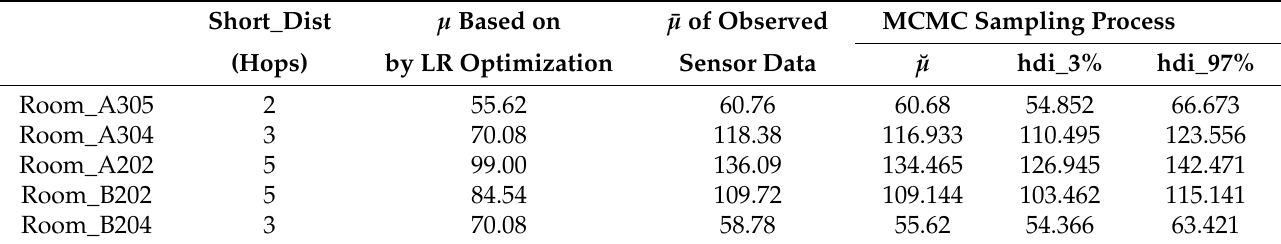
Figure 12. Examples of approximated µ values of ∆ t , where ( a-1 , b-1 , c-1 ) show the mean value result on the observed raw data, while ( a-2 , b-2 , c-2 ) show the approximated ∆ t after MCMC posterior sampling process. Table 4. MCMC sampling results ∆ t of several representative spaces.